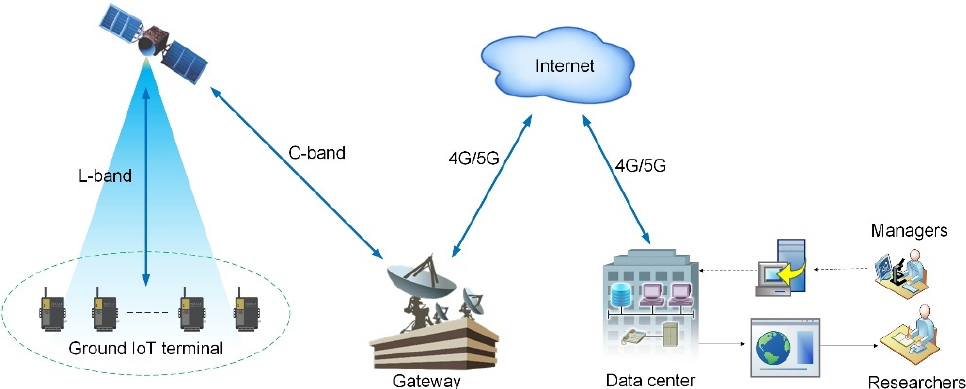
Figure 3. Interaction of diagram of the satellite-enabled IoRT system.